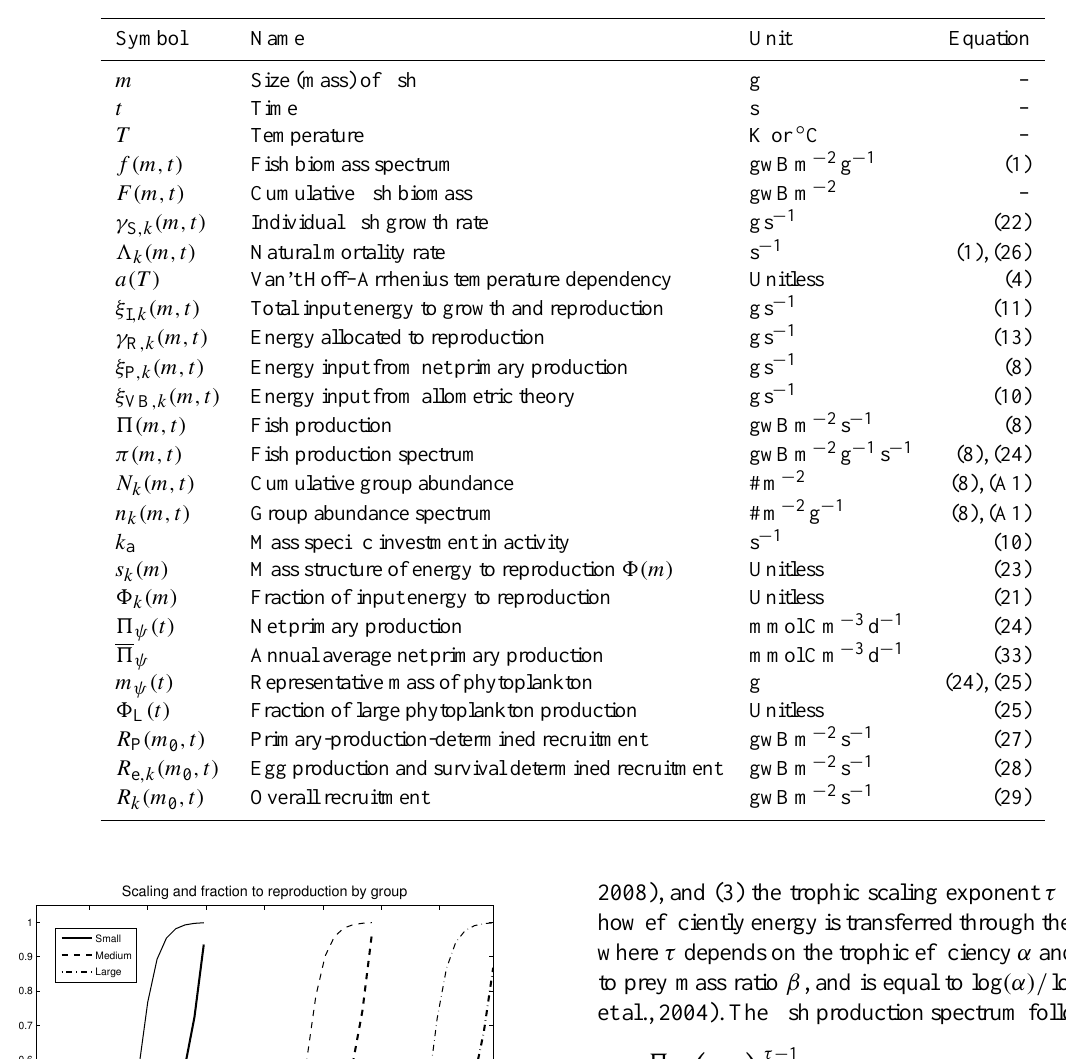
Table 2. Ecological model variables.